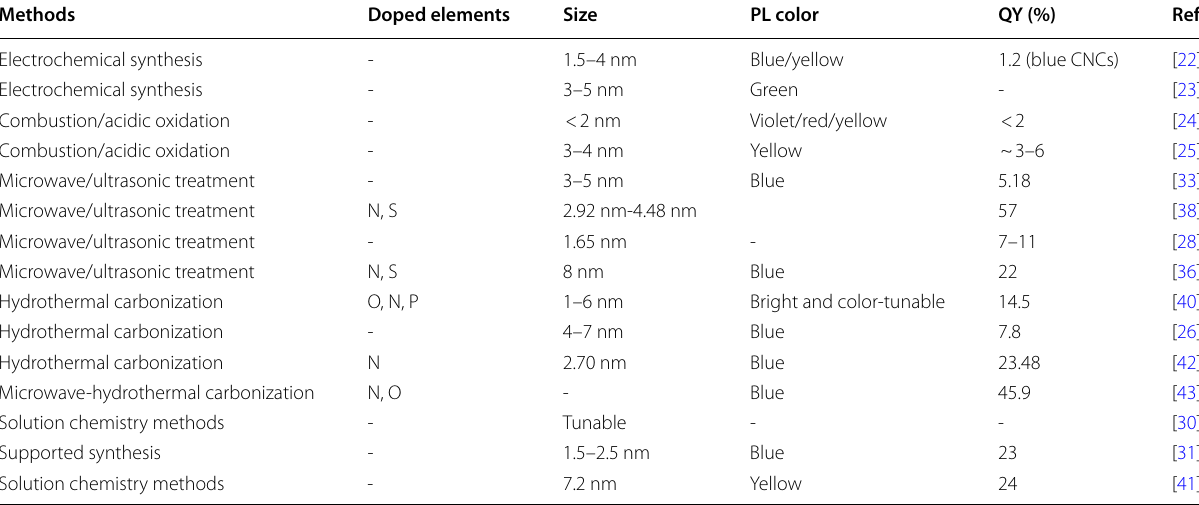
Table 1 Chemical synthetic methods and properties of carbon dots